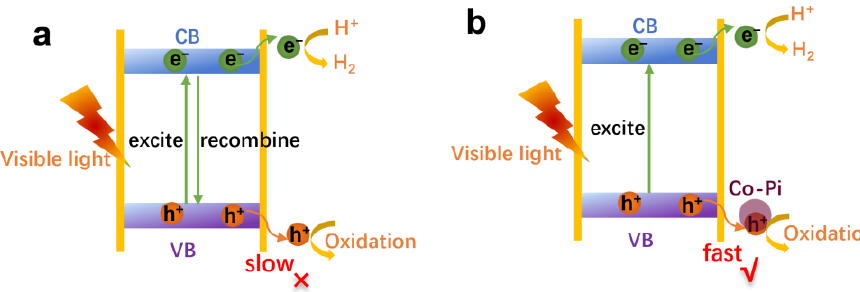
Figure 7. Photogenerated charge transfer process of ( a ) CIS, and ( b ) Co-Pi/CIS.